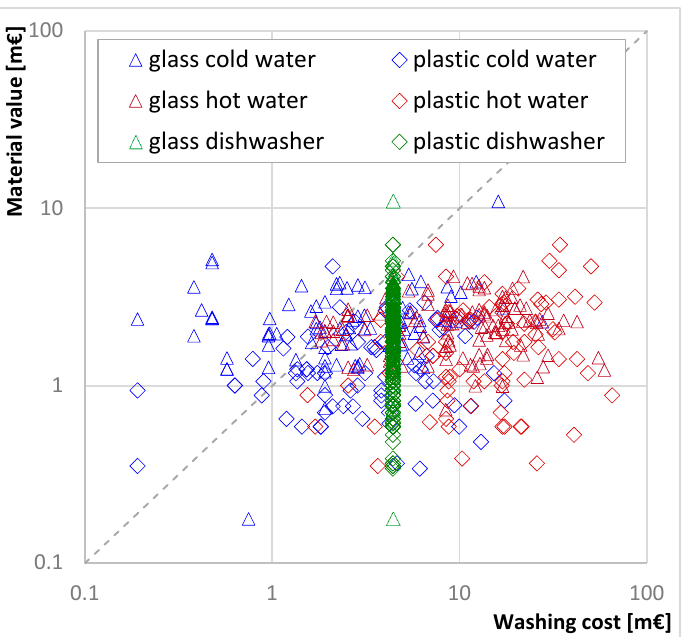
Figure 7. Comparison of the value of recyclable materials and the cost of cleaning in 2022, including the